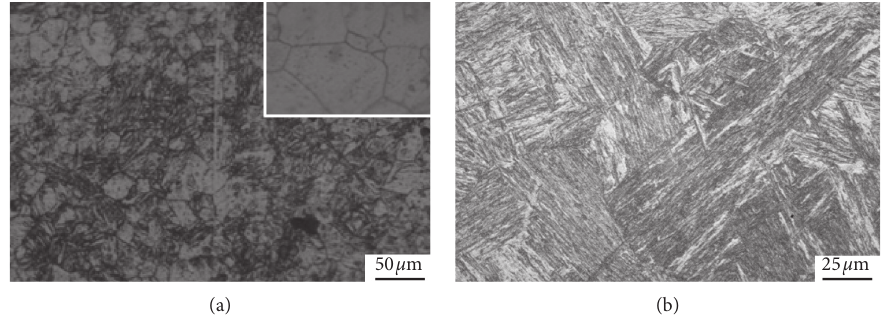
Figure 11: (a) Microstructure at 900 ° C; (b) microstructure after the synchronous quenching process.